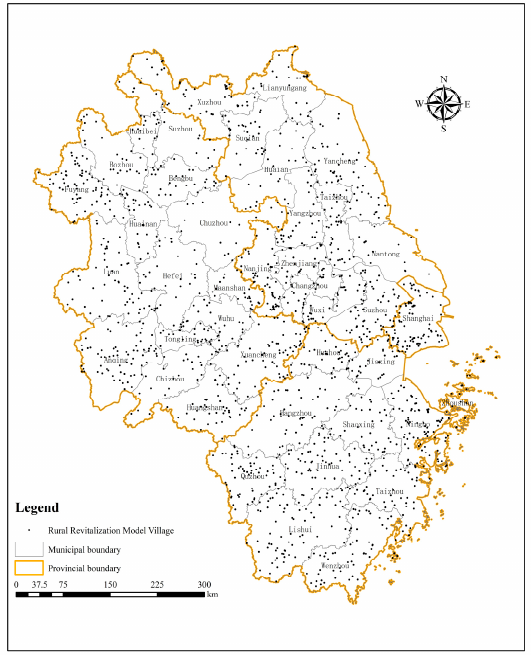
Figure 2. Distribution map of rural revitalization model villages in the YRD.